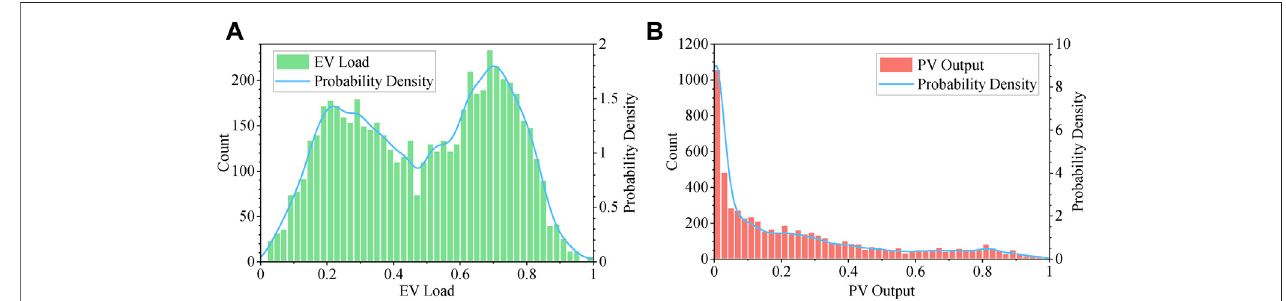
FIGURE 9 | Results of KDE (A) is the KDE result of EV loads with h as 0.02485 (B) is the KDE result of PV outputs with h as 0.02486.